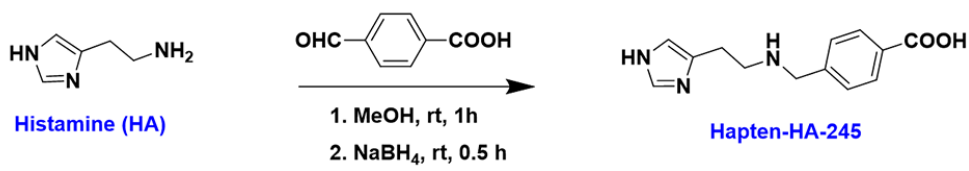
Figure 1. Structure and synthetic route of hapten for histamine.